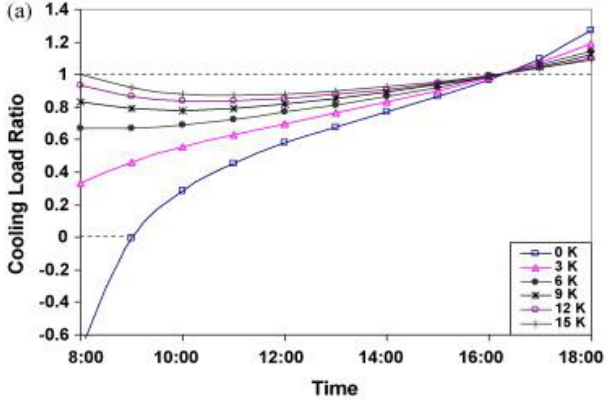
Fig. 5. Profiles of cooling load ratio as a function of the temperature differences between indoor and outdoor air (Sources: [28]).